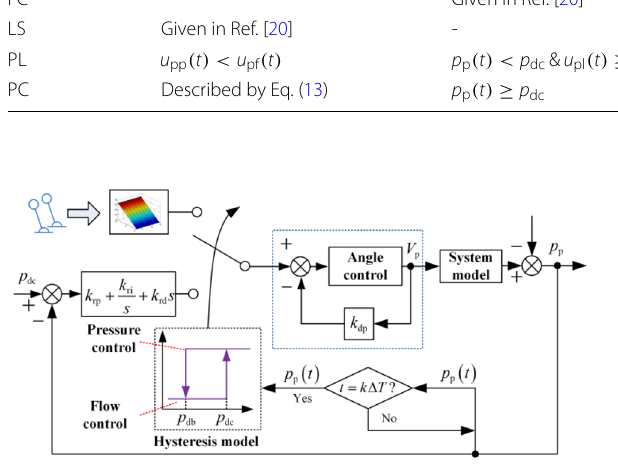
Figure 3 Block diagram of hysteresis switching rule